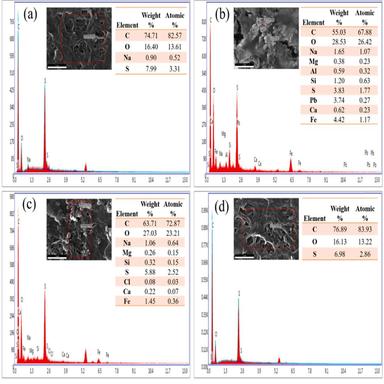
Energy-dispersive spectroscopy: (a) Virgin membrane, (b) Membrane fouled by ROC, (c) Membrane fouled by ROC pretreated with AOPs-UF, (d) Mixed cleaned membrane.